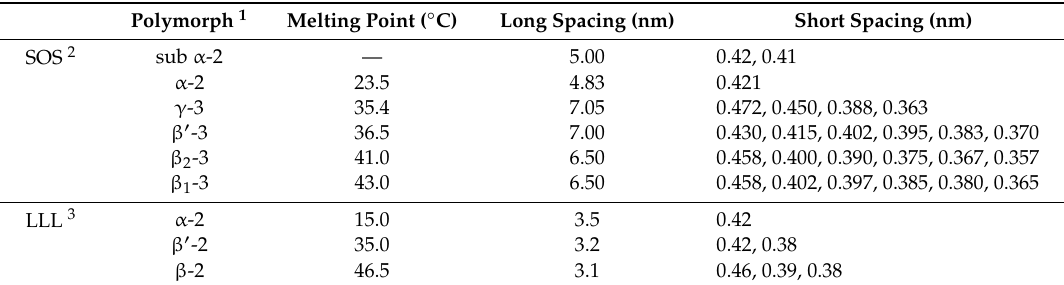
Table 1. Crystal polymorphs of 1,3-distearoyl-2-oleoyl- sn -glycerol (SOS) and trilaurin